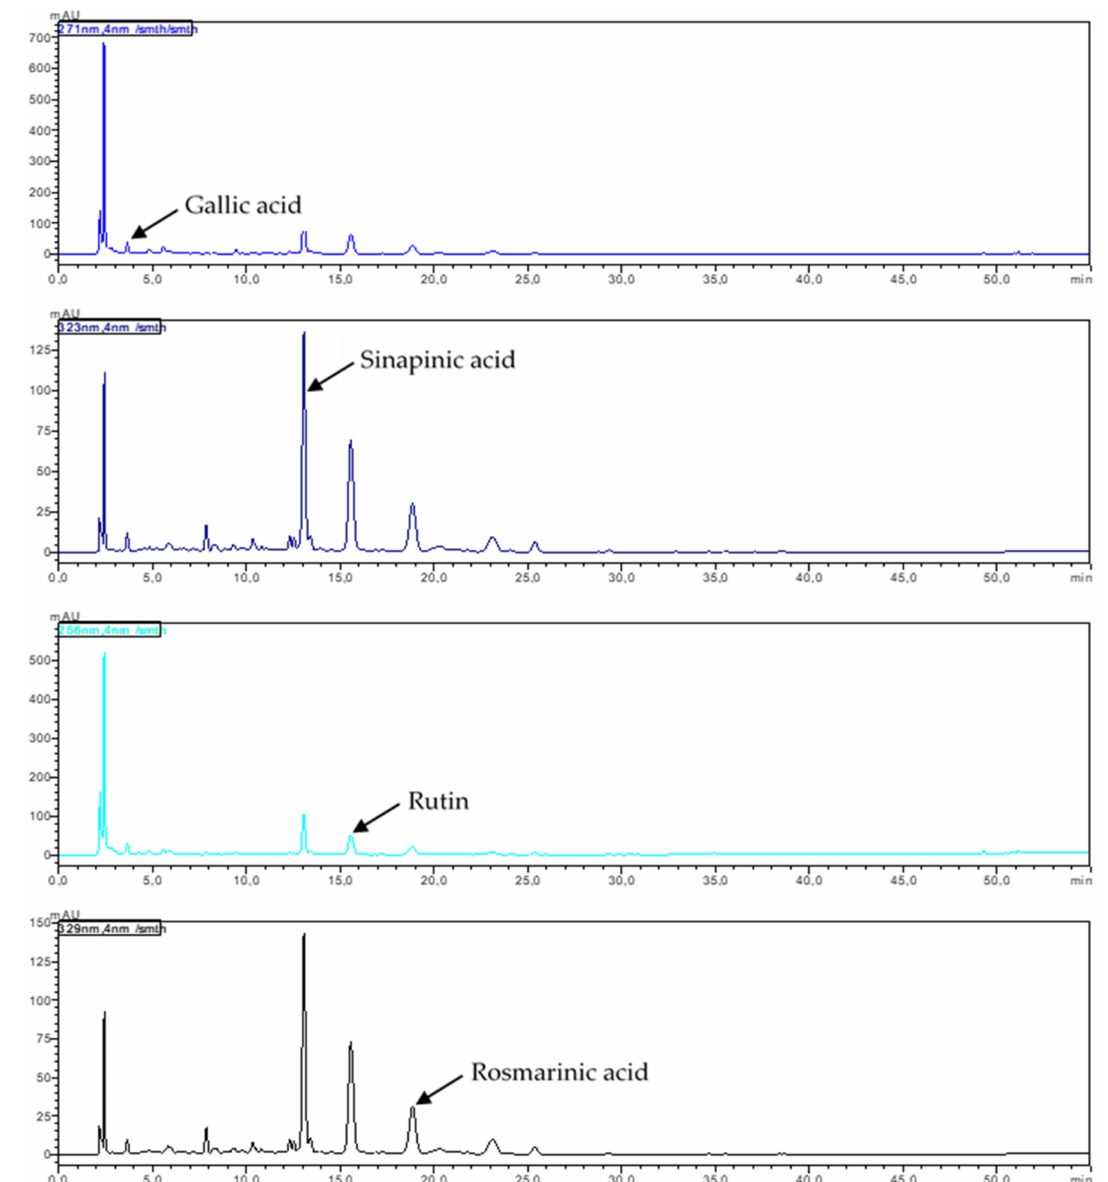
Figure 1. HPLC-DAD chromatograms of selected polyphenols identified in the juice from young shoots of